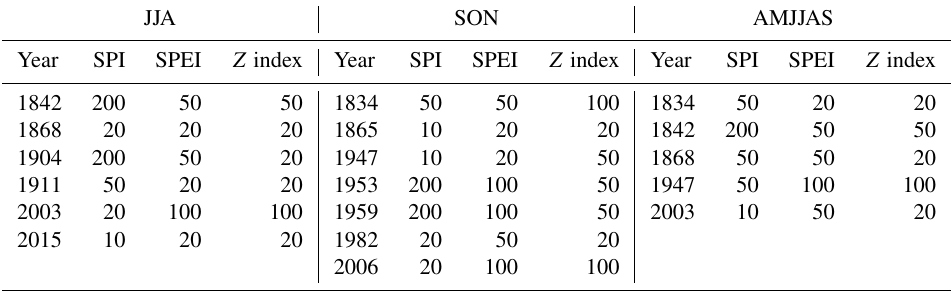
Table 3. Overview of seasonal (JJA, SON) and summer half-year (AMJJAS) extreme droughts in the Czech Lands selected according to series of SPI, SPEI and Z index with a return period of N ≥ 20 years ( N ≥ 10 years for SPI) in the instrumental 1804–2017 period.